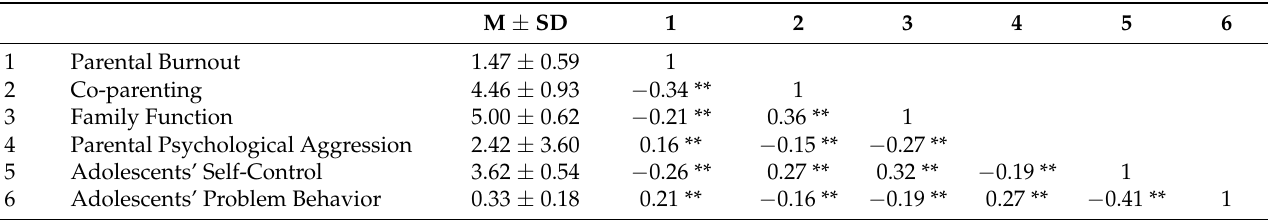
Table 1. Descriptive statistics and correlations between study